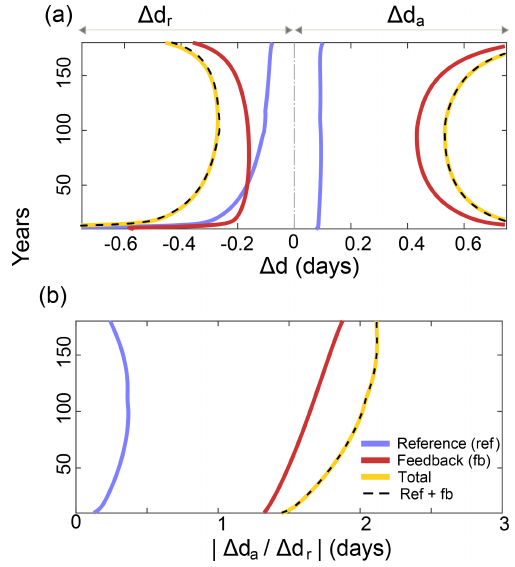
Figure A2. Thermodynamic response of sea ice seasonality to warming in the 1-D model. (a) Evolution over the years of the an- nual contributors to changes in ice retreat and advance date, as simu- lated by the 1-D model. The yellow line gives the total response (cid:49)d r (resp. (cid:49)d a ) as diagnosed from model output. The blue curve gives the reference response (cid:49)d ref r (resp. (cid:49)d ref a ) to the radiative forcing perturbation as calculated with Eq. (A11) (resp. A16). The red curve gives the feedback response (cid:49)d fb r (resp. (cid:49)d fb a ) , attributed to the feedback from d a (resp. d r ) , calculated with Eqs. (A9) and (A10) (resp. A13 and A15). The black dashed line testifies that the sum of reference and feedback responses matches the total. (b) Evolution over the years of the simulated freeze-up amplification ratio in the 1-D model. The yellow curve gives the freeze-up amplification R , calculated as the ratio of the total response in d a ( (cid:49)d a ) divided by the total response in d r ( (cid:49)d r ) , as diagnosed from the 1-D model. The blue curve gives the contribution of the reference response to the freeze-up amplification ratio ( (cid:49)d ref a /(cid:49)d r ) . The red curve gives the contribution of the summer feedbacks ( (cid:49)d ref a /(cid:49)d r = λ s ) . The black dashed line testifies that the sum of reference and feedback contributions matches the